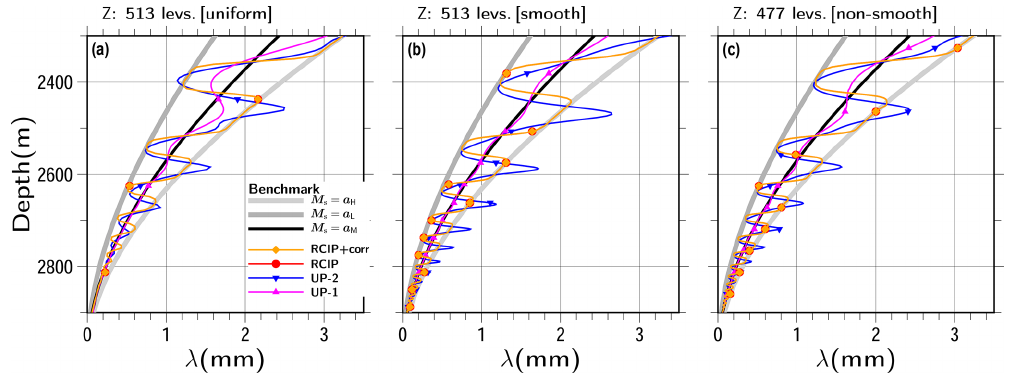
Figure 18. Same as Fig. 7c, except for the vertical resolution as (a) uniform grid spacing of 513 levels, (b) smooth non-uniform grid spacing of 513 levels, and (c) non-smooth non-uniform grid spacing of 477 levels. The results at 2000kyr covering the depths from 2300 to 2900m are shown.